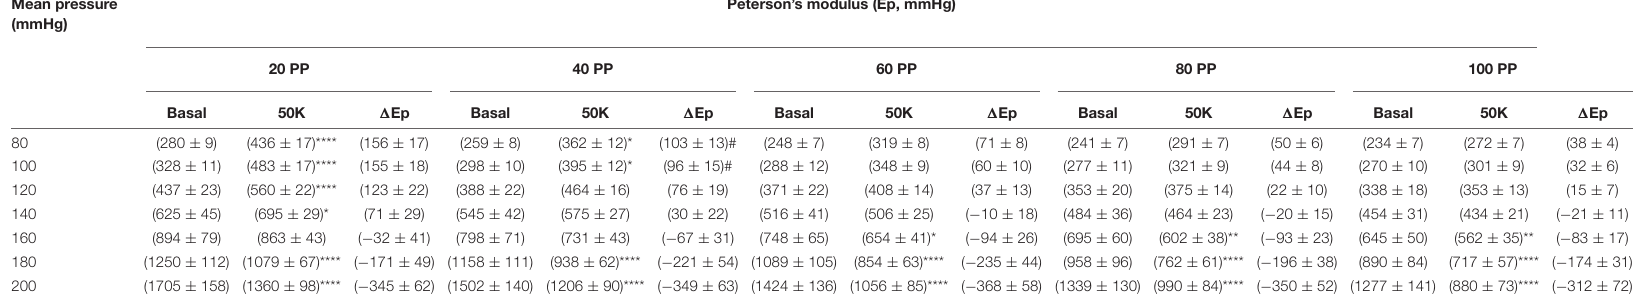
Comparisons are made between the Ep at “50K” and “Basal” (conditions) at the same pulse pressure. Data is expressed as (Mean ± SEM), n = 7. *p < 0.05; **p < 0.01; ***p < 0.001; ****p < 0.0001, #P < 0.05 (“#” = Compared to the (cid:49) Ep at 20PP), Repeated measures two-way ANOVA with Sidak post hoc test for multiple comparisons. PP, pulse pressure (mmHg), (cid:49) Ep, Ep 50K –Ep Basal .